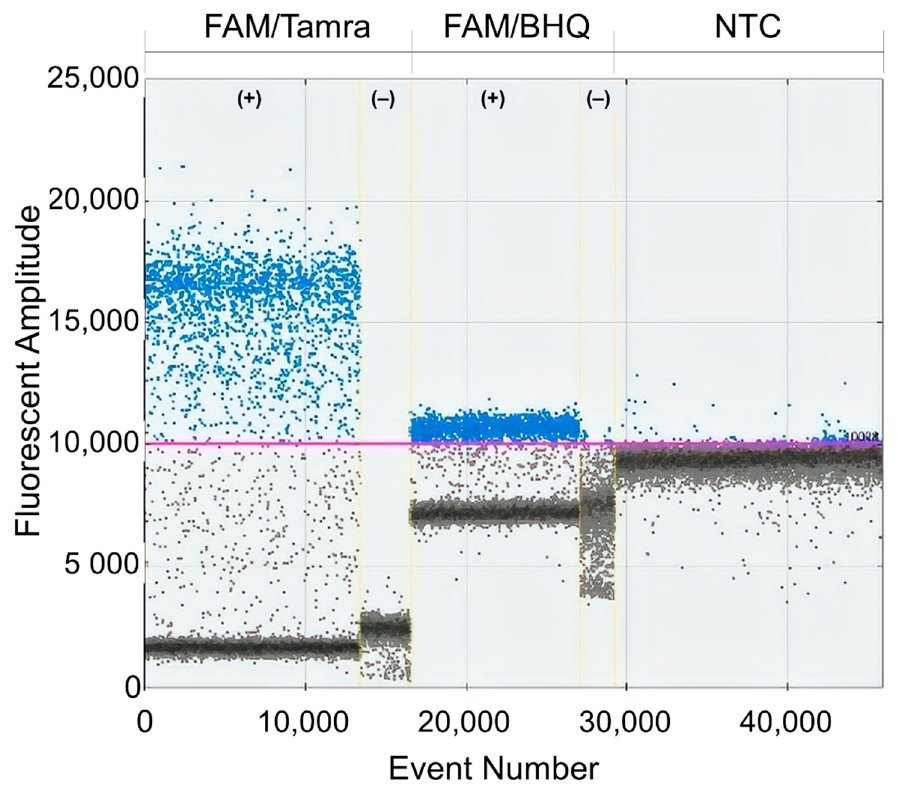
Figure 1. Comparison of FAM/Tamra and FAM/BHQ-labeled probes. 1D-plot results of FAM/Tamra and FAM/BHQ-labeled probes: X-axis represents the total number of droplets. Y-axis represents detected fluorescent amplitude with positive sample (+) by using in vitro RNA standard as a template. Negative sample ( − ) refers to the negative control (NTC) or blank where water was used as a template.